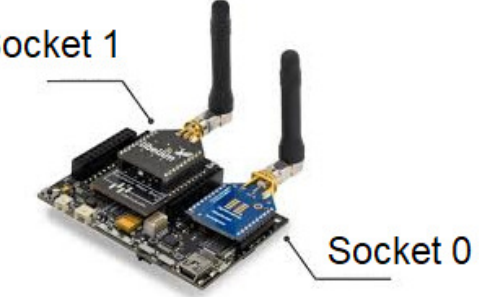
Figure 10. The sink node with two ZigBee modules mounted on Waspmote Microcontroller. The first one operates at 2.4 GHz and is mounted on socket 0, while the other one operates at 868 MHz and is mounted on socket 1 using the wireless expansion